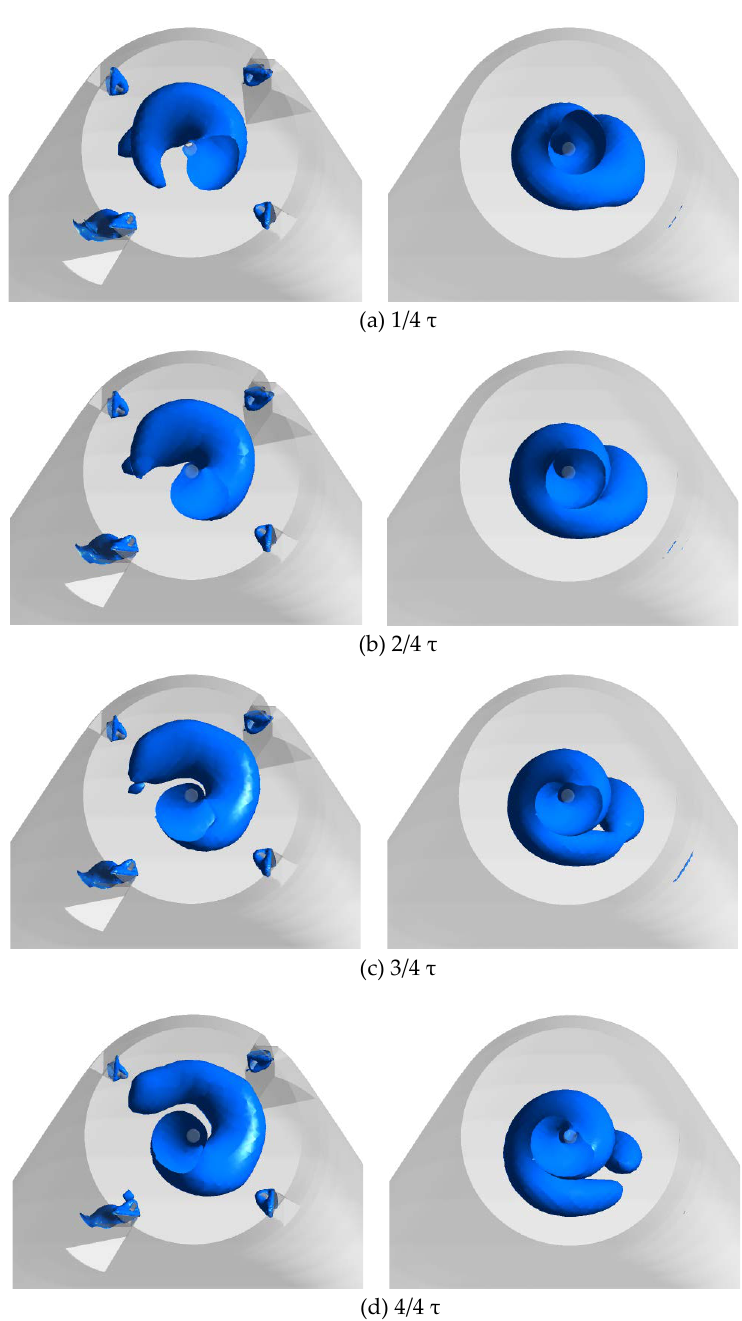
Figure 13. Iso-surface distributions of pressure in the DT by the top view from the runner at the GV at 16° (left column) with and (right column) without anti-cavity fins during one revolution of the runner. (a) 1/4, (b) 2/4, (c) 3/4, and (d ) 4/4 τ.